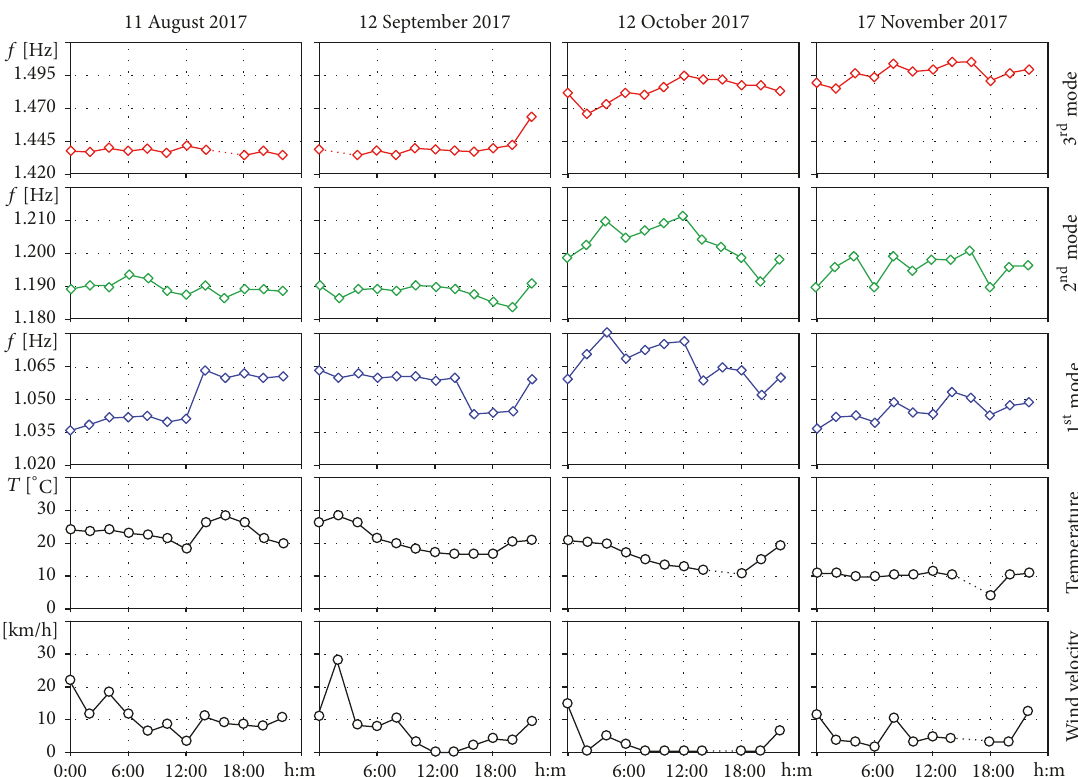
Figure 11: Daily evolution of the air temperature and wind velocity for selected days and histories of identified fundamental